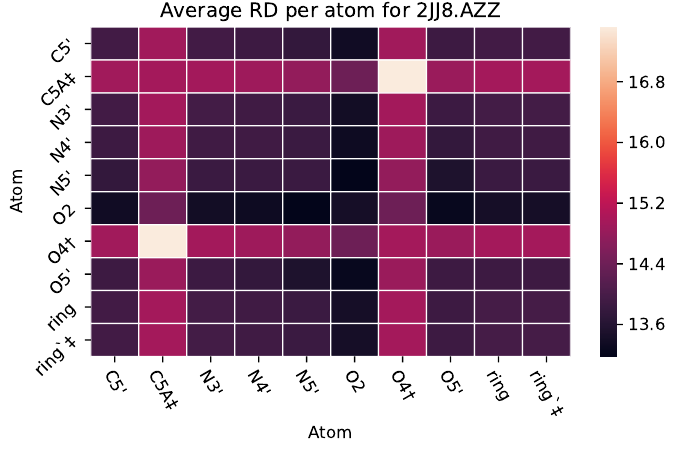
Figure 5. Heat map for PairCut i , j , Equation (2). The x and y axes represent all the atoms in a given ligand, while the colors represent the rigidity distance of a protein when each pairwise set of atoms (i.e., C5 (cid:48) and O2) is contained in a ligand variant. † = Hydrogen Bond ‡ = Hydrophobic